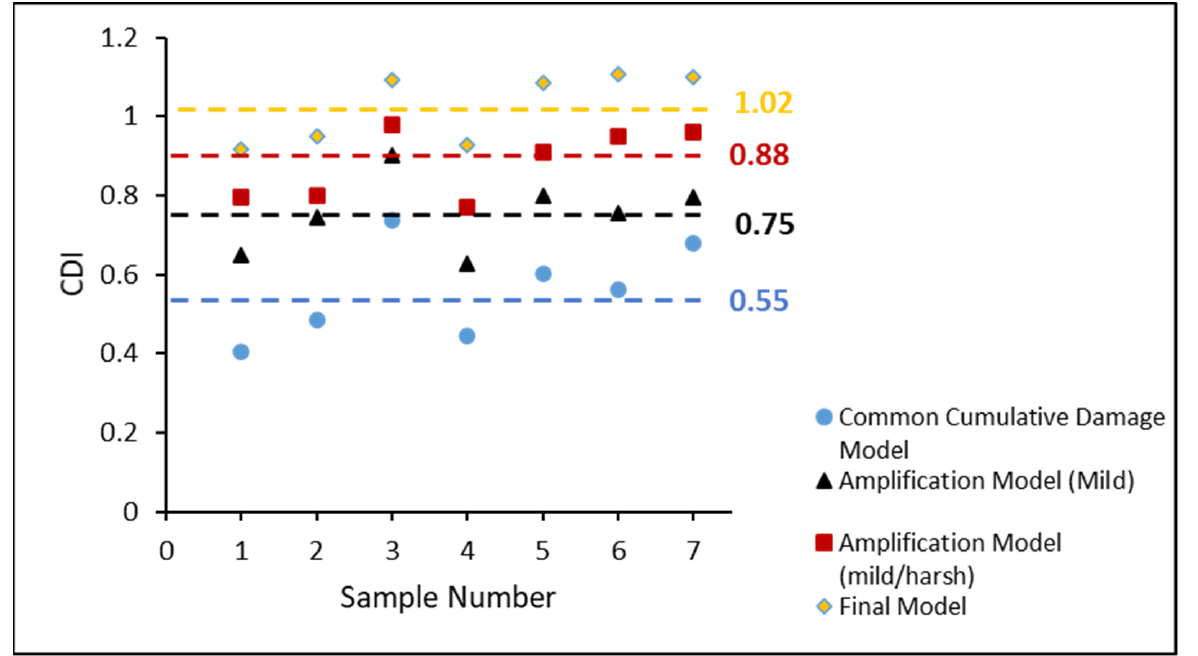
Figure 17. CDI comparison of non-aged SAC305 individual solder joint in varying stress amplitude test.